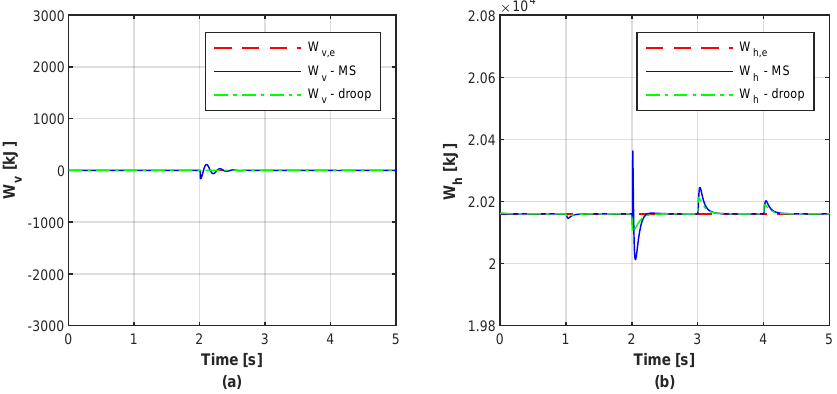
Figure 17. Energy dynamics response from terminal 3: ( a ) energy difference W v ; ( b ) total energy W h .